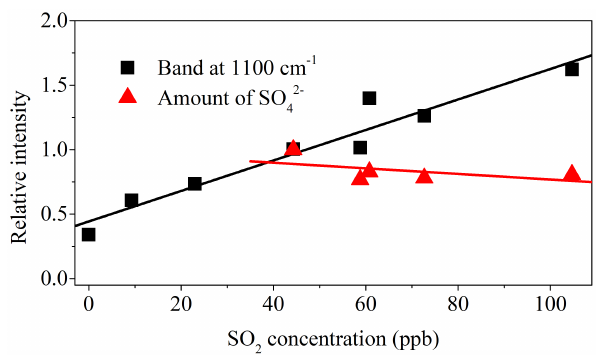
Figure 6. Negative ion mode ESI mass spectrum of SOA generated from the photooxidation of cyclohexene in the presence of SO 2 . Figure 5. The relative intensity of the FTIR band at 1100cm − 1 Red peaks correspond to organic compounds containing the sulfate (square) and the amount of SO 2 − (triangle) normalized to SOA 4 group. The mass resolution is 10 5 . mass. The 1100cm − 1 band intensity and the amount of SO 2 − were 4 divided by the formed SOA mass, firstly. Subsequently, the results Table 2. Accurate mass fittings for main products and measured of both FTIR bands at 1100cm − 1 and the amount of SO 2 − divided 4 organosulfates ions in ESI negative ion mode from cyclohexene by SOA mass were set to 1 at the experiment which initial SO 2 photooxidation in the presence of SO 2 under high-NO x concentration was 44.3ppb.